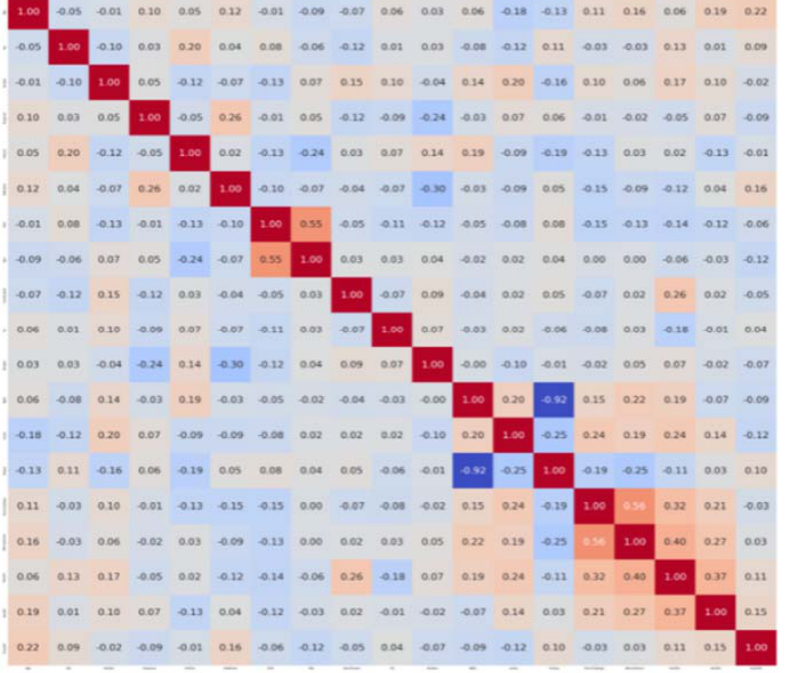
Figure 6. Correlation matrix (first 100 data rows).